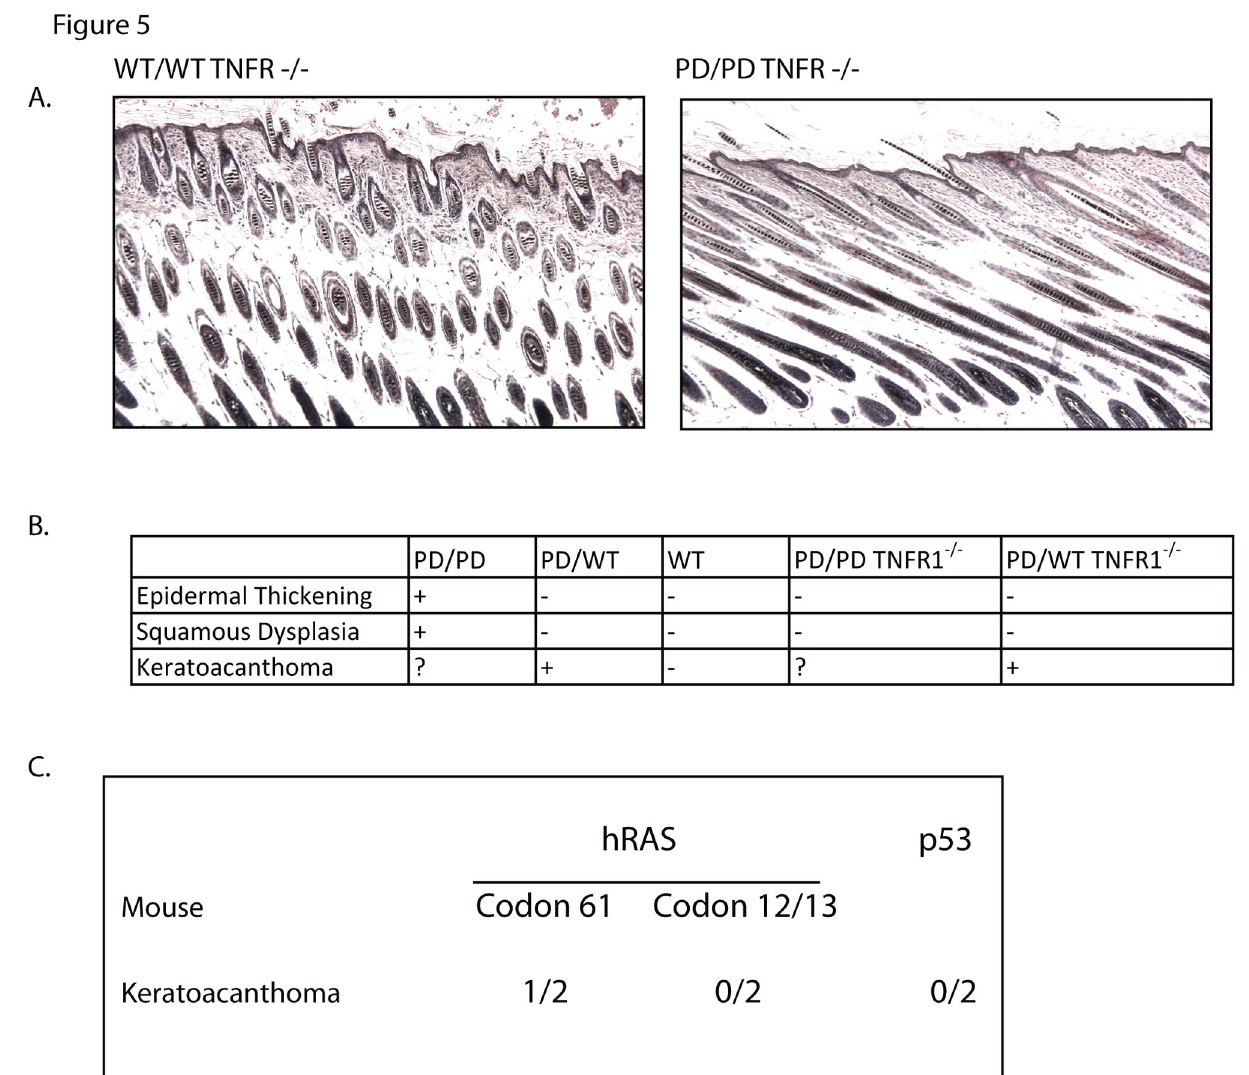
Figure 5. Keratoacanthoma development in the PD mice in the absence of TNF signaling. Chemical carcinogenesis study in which PD heterozygotes and littermates lack TNFR1 expression. A. rela PD/PD tnfrsf1a -/- knockout skin is normal histologically compared to RelA tnfrsf1a -/- . B. Summary findings among various genotypes, representing evaluation of 20 mice in each cohort except for the PD homozygous cohort, which included 10 mice. C. Mutational analysis of PD mice for Hras and Tp53